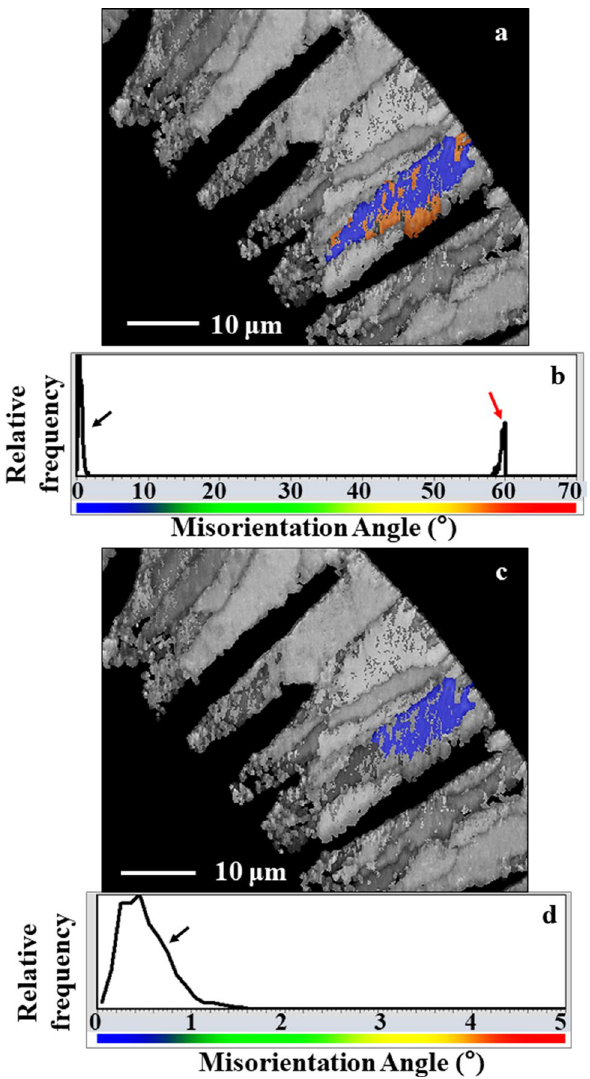
Figure 6. Twinned crystals and twin individuals/domains in Pulleniatina obliquiloculata shells. ( a ), ( c ) EBSD band contrast measurement (given in grey) obtained on a cross-section through the shell wall. In color in ( a ) and ( c ) are the corresponding individuals/domains of a twinned, cone-shaped, crystal unit. The twin individuals/domains are shown with blue and orange colors ( a ). These are misoriented to each other by 60°, as the two peaks (black and red arrows in ( b )) in the relative frequency—misorientation angle diagram in ( b ) demonstrate. The two peaks in ( b ) are sharp, hence, misorientation of calcite crystallites within each of the twin individuals/domains is very low. ( d ): It is shown for one twin individual/domain that calcite crystallite misorientation is well below 1°. Hence, the calcite within each twin individual/domain is